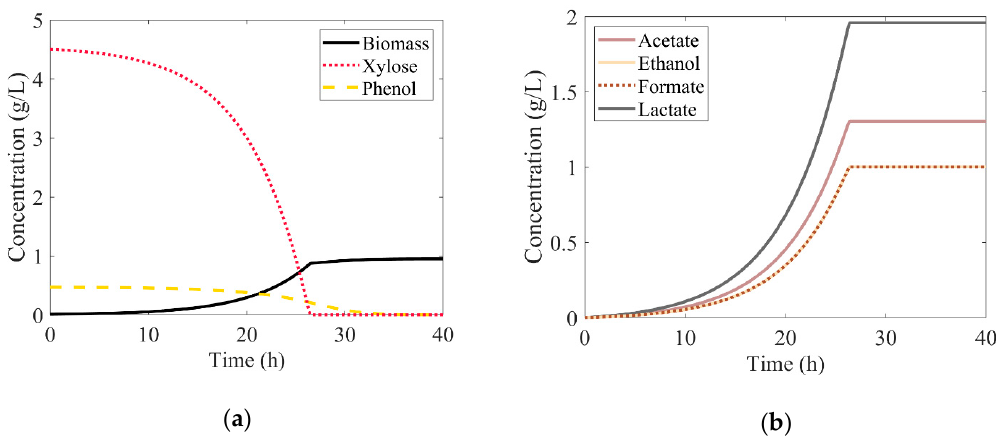
Figure 5. Dynamic flux balance analysis simulations of xylose and phenol co-metabolism in A. acidocaldarius with DFBAlab—( a ) biomass (black), xylose (red), and phenol (yellow) as a function of time; ( b ) byproduct profiles resulting from the same simulation (lactate, acetate, and ethanol / formate, in order of decreasing